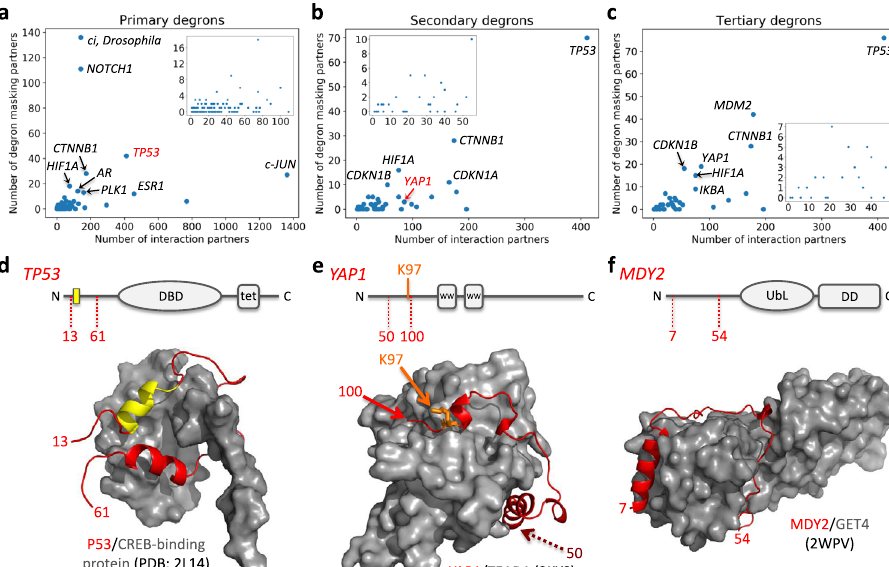
Fig. 2 Degron masking by PPIs. Plots showing the total number of experimentally identi fi ed PPI partners from IntAct (each data point corresponds to one substrate) versus the number of partners whose known binding site overlaps with ( a ) primary, ( b ) secondary, and ( c ) tertiary degrons. Substrates for which at least 10 degron masking APs were identi fi ed are labeled. The insets show a zoom-in view of the clustered data points at the bottom left of each plot. d – f Examples from each degron category where available structural data showed the degron containing segment in complex with a non-UPS masking partner, AP. Domain diagrams showing the location of the degron element and the substrate segment (in red) present in the crystal structure of the substrate-AP complex; drawn with PyMol